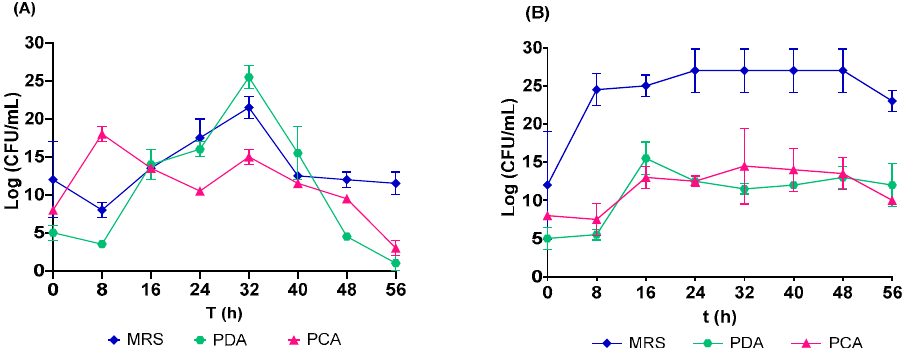
Figure 2. Microbial profile of the native fermentation ( A ) and controlled with Lp ( B ) of the C. ficifolia juice for 56 h (MRS = Man, Rogosa, and Sharpe, PDA = potato dextrose agar, PCA = standard count agar). Table 2. Kinetic of growth of native and controlled fermentation ( L. plantarum ) of the C. ficifolia juice at 30 ◦ C (Mean ± S.D., n = 3). Specific growth rate µ (h − 1 ) was determined using the linear equation of the exponential growth.